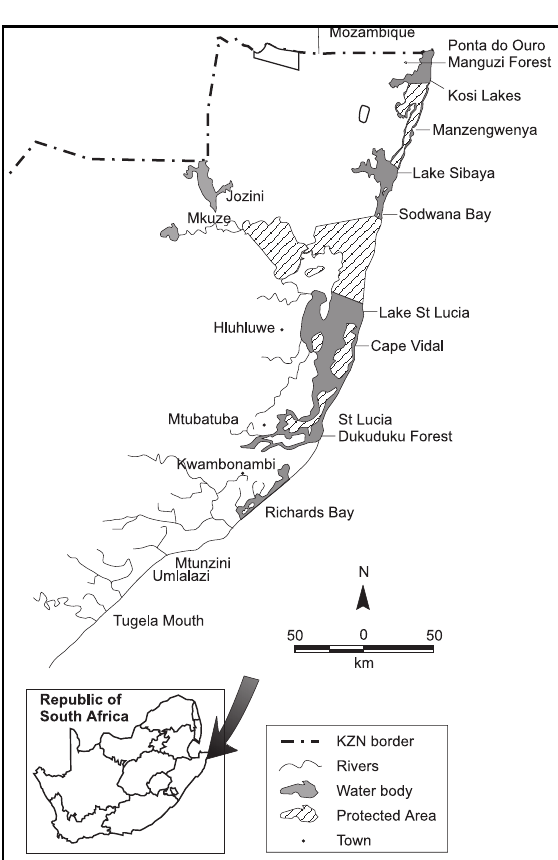
Fig. 1. Map of northern KwaZulu/Natal showing the main conser- vation protected areas and localities important in the known dis- tribution of B.